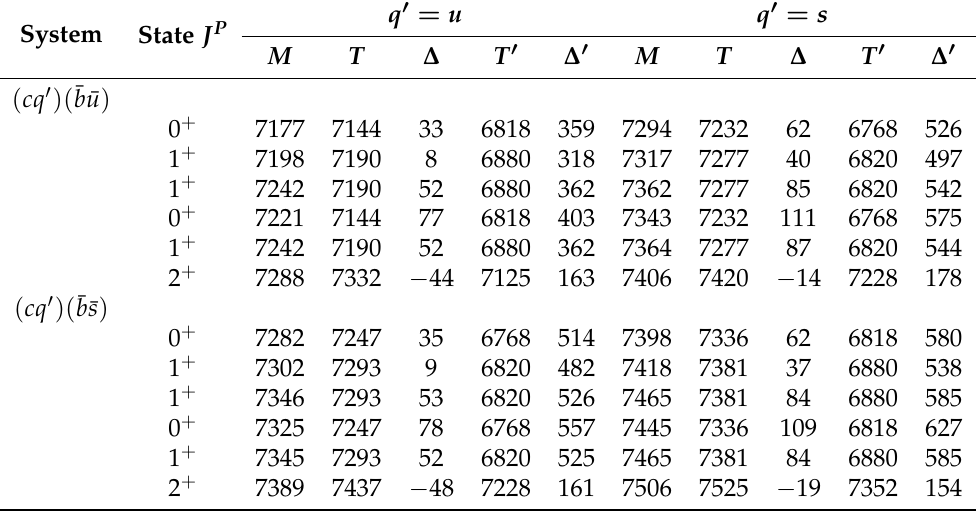
Table 8. Masses M of diquark ( cq (cid:48) )–antidiquark (¯ b ¯ q ) states. T is the lowest threshold for decays into two heavy-light ( Q ¯ q ) mesons and ∆ = M − T ; T (cid:48) is the threshold for decays into the B meson ( q (cid:48) ¯ q ), and ∆ (cid:48) = M − T (cid:48) . All values are given in